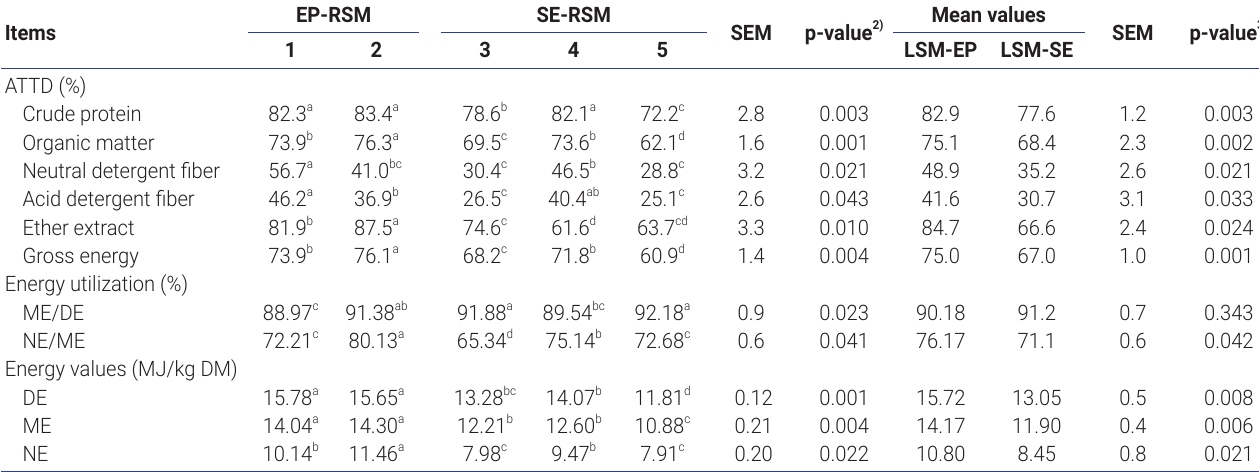
Table 5. Energy utilization and energy value of the five ingredients 1)